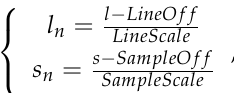
Among them, LineO f f , SampleO f f are the translation values of the image-side co- ordinates, respectively, and LineScale , SampleScale are the zoom values of the image-side coordinates,